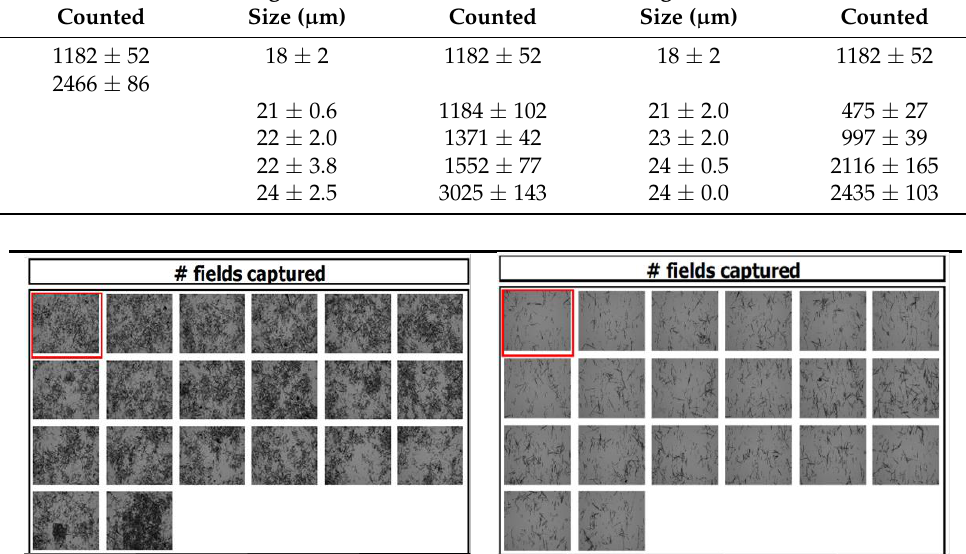
Table 3. Results of particles size and number by Tali ® Image -Based Cytometer.